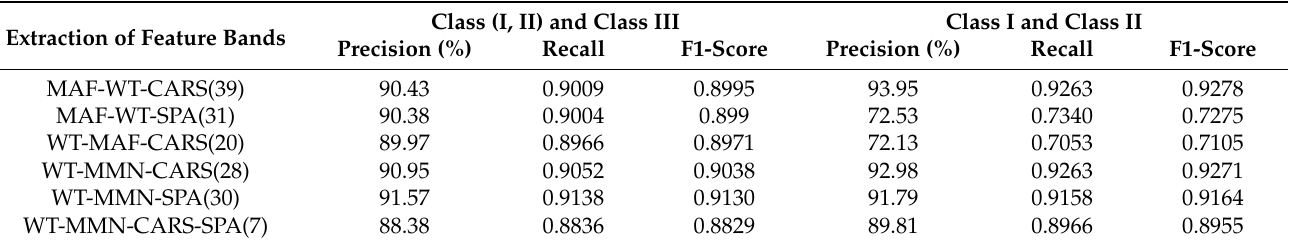
Table 4. Precision, Recall, and F1-score of the classification for different methods of extraction of feature bands.